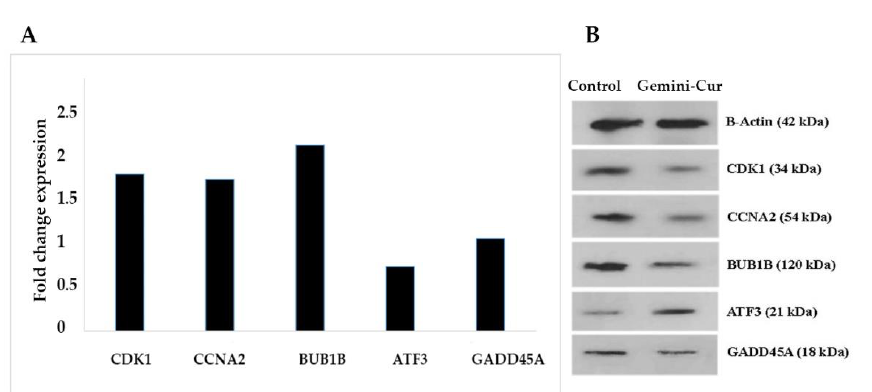
Figure 6. Validation of the expression of selected genes by real-time PCR and Western blotting. Nearly all genes except GADD45A validate findings from RNA seq. data. ( A ) The data show relative expression of genes compared to non-treated controls. ( B ) Blots illustrate protein expression in control and treated cells.